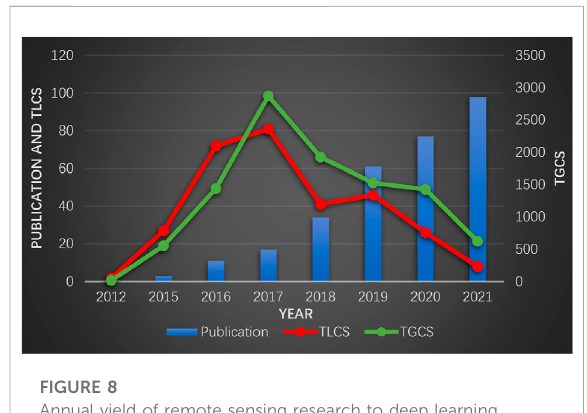
FIGURE 8 Annual yield of remote sensing research to deep